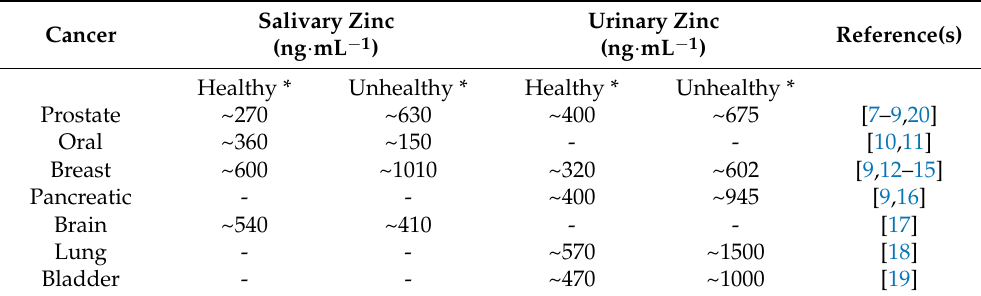
Table 1. Some examples of abnormal expression of salivary and urinary zinc for different types of